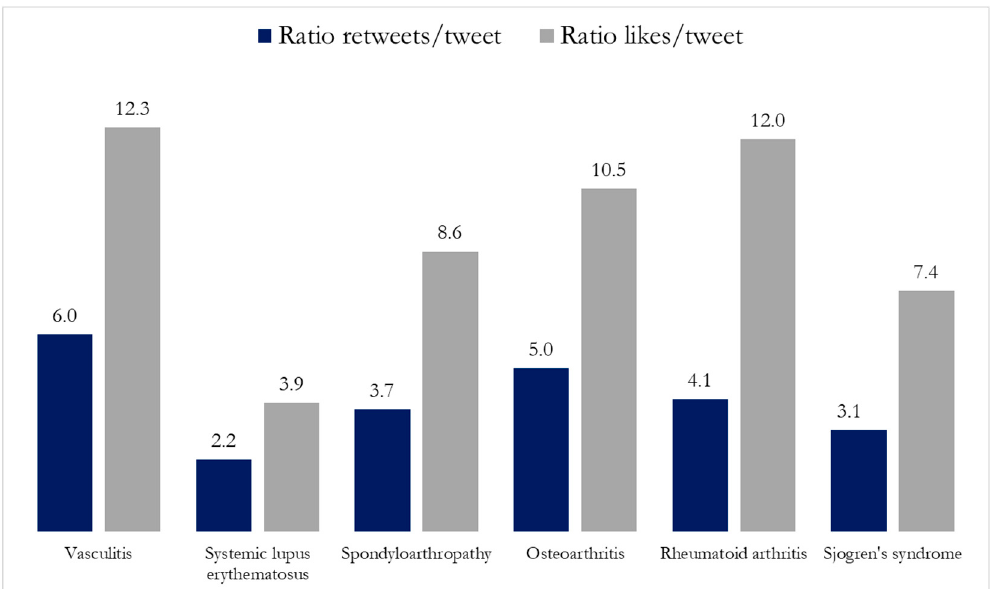
Figure 3. Ratio of retweets and likes per tweet related to rheumatic diseases. Spondyloarthropathy includes: spondyloarthritis. ankylosing spondylitis, psoriatic arthritis, reactive arthritis, and spondylitis. The statistical significance of the ratios difference between types of rheumatic diseases was obtained by the analysis of variance (ANOVA). The p value for retweets per tweet is < 0.001 and p value for likes per tweet is 0.062.